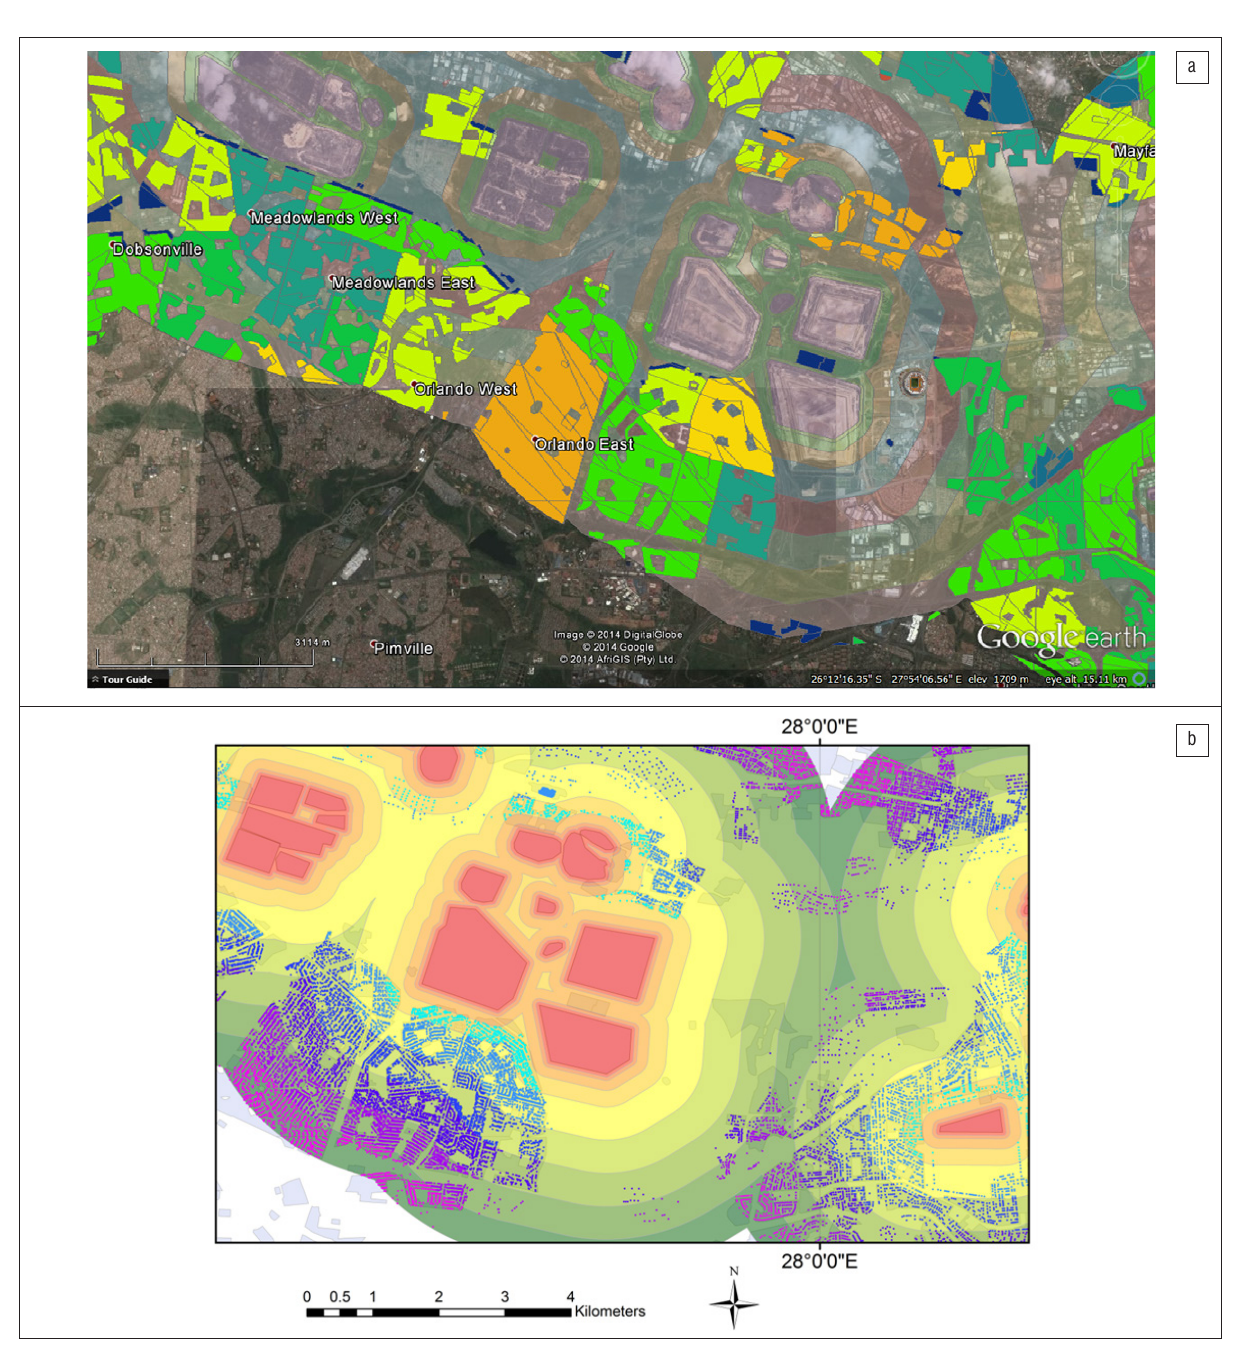
Figure 3: (a) Map of Crown Gold Recoveries region showing overlay of distance buffers (transparent and changing colour every 500 m) and residential areas coloured (blue = low, to orange = high) to reflect the average population density in the relevant census 2001 22 enumerator area. (b) Map showing individual dwellings recorded for the 2011 census, 23 coloured based on distance to the tailings storage facilities. Buffers coloured red to green in 500 m steps up to 3 km, dwellings as small squares coloured cyan to